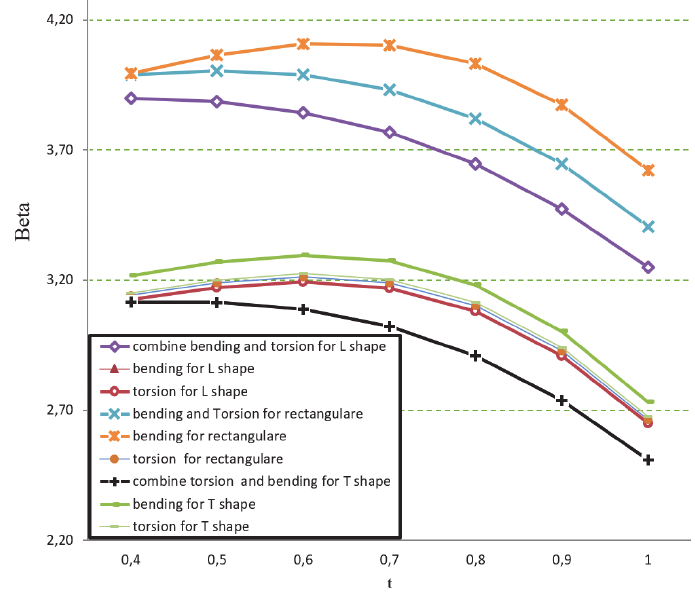
Figure 5: ACI beta index for torsion-bending.